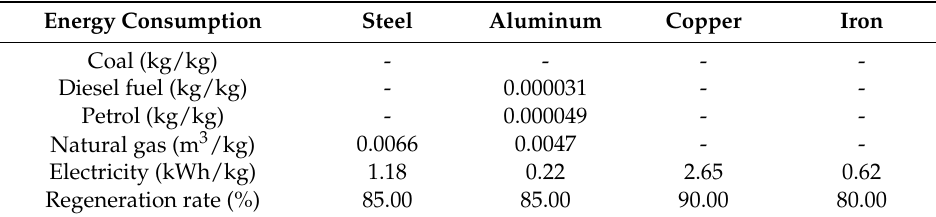
Table 5. The energy consumption in the end-of-life stage.